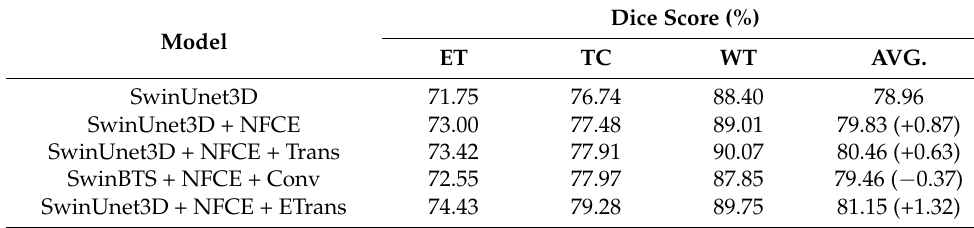
Table 5. Ablation experiments of each